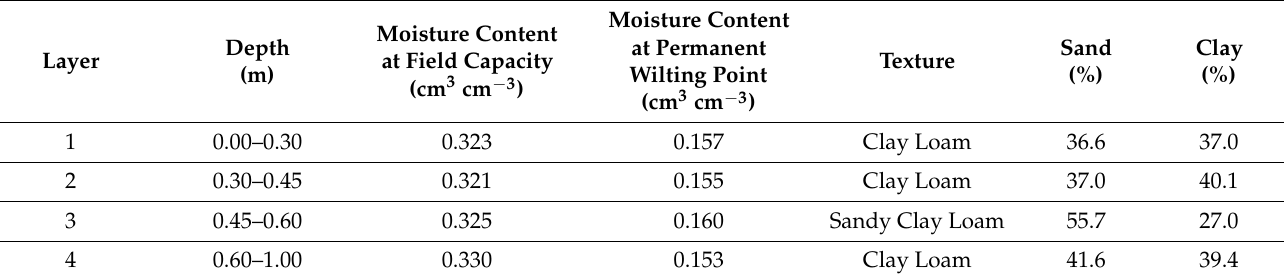
Table 1. Soil properties determined in the study